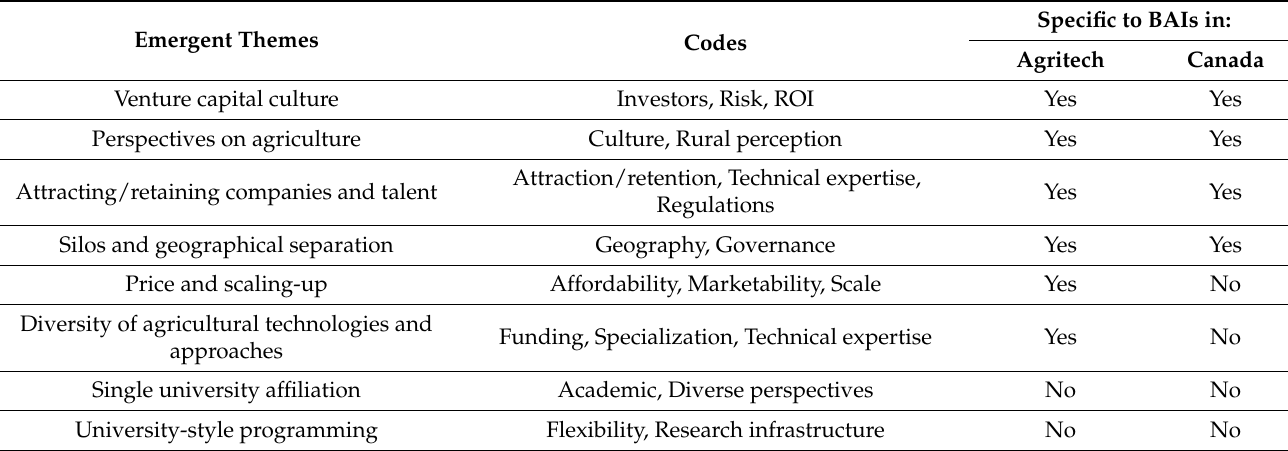
Table 4. Challenges and barriers related to increasing agritech incubator and accelerator